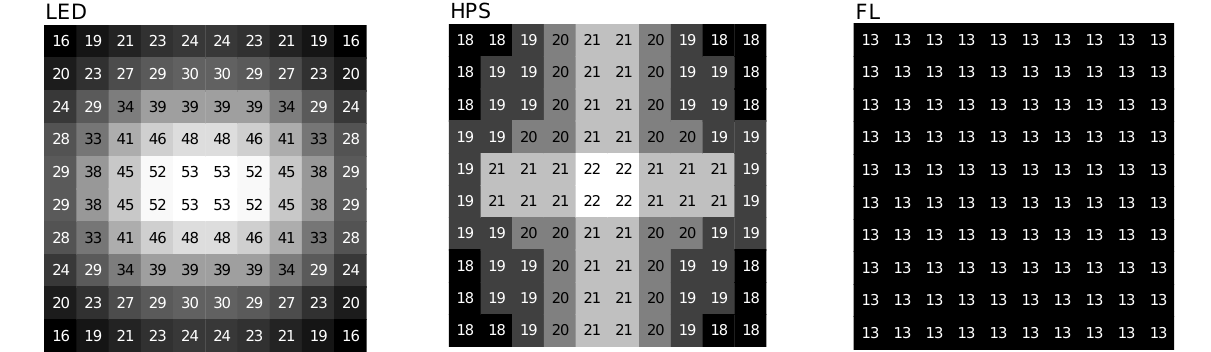
Figure 3. Irradiance profiles (W m − 2 nm − 1 ) of the experimental plots (1 m 2 ) underneath each supplemental lighting system. (LED = light-emitting diode, HPS = high-pressure sodium lamp, FL = fluorescent light).